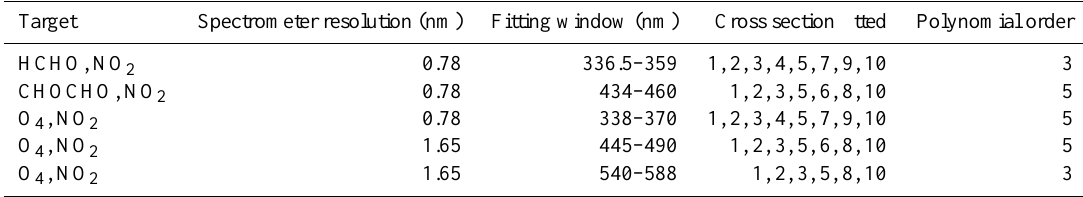
Table 4. Summary of the DOAS fitting